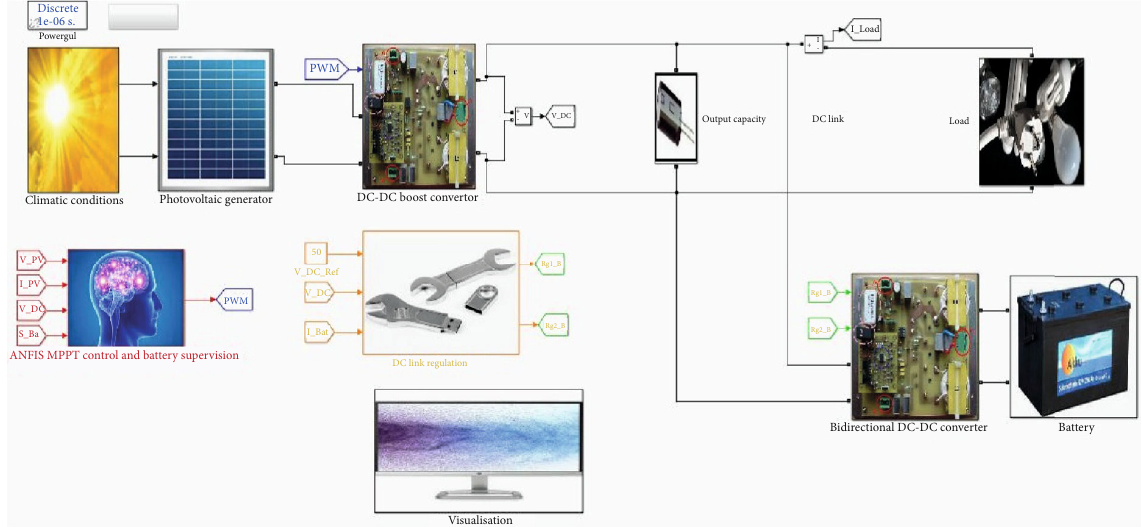
Figure 3: MATLAB/Simulink diagram of the PV system.